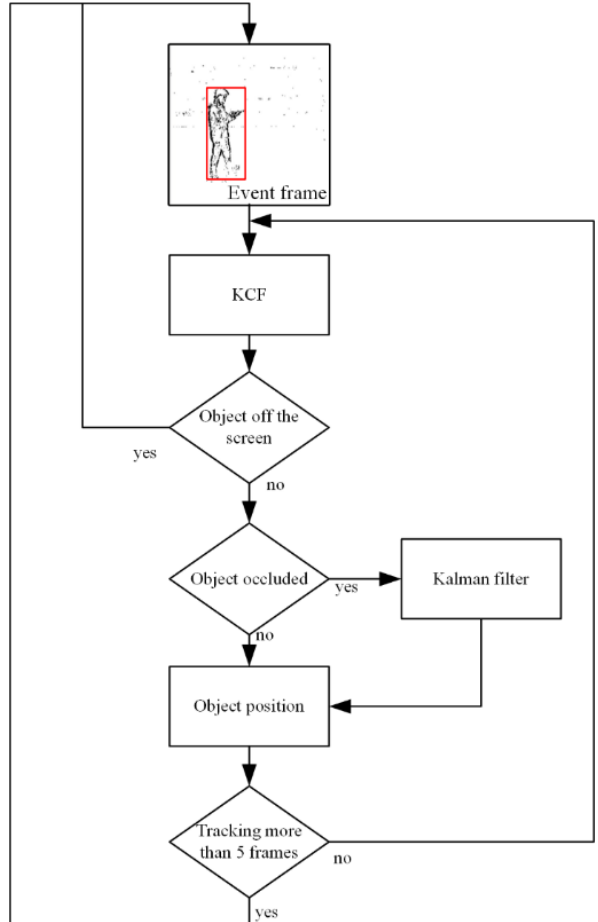
Figure 9. Flow chart of event-based tracking by improved KCF.